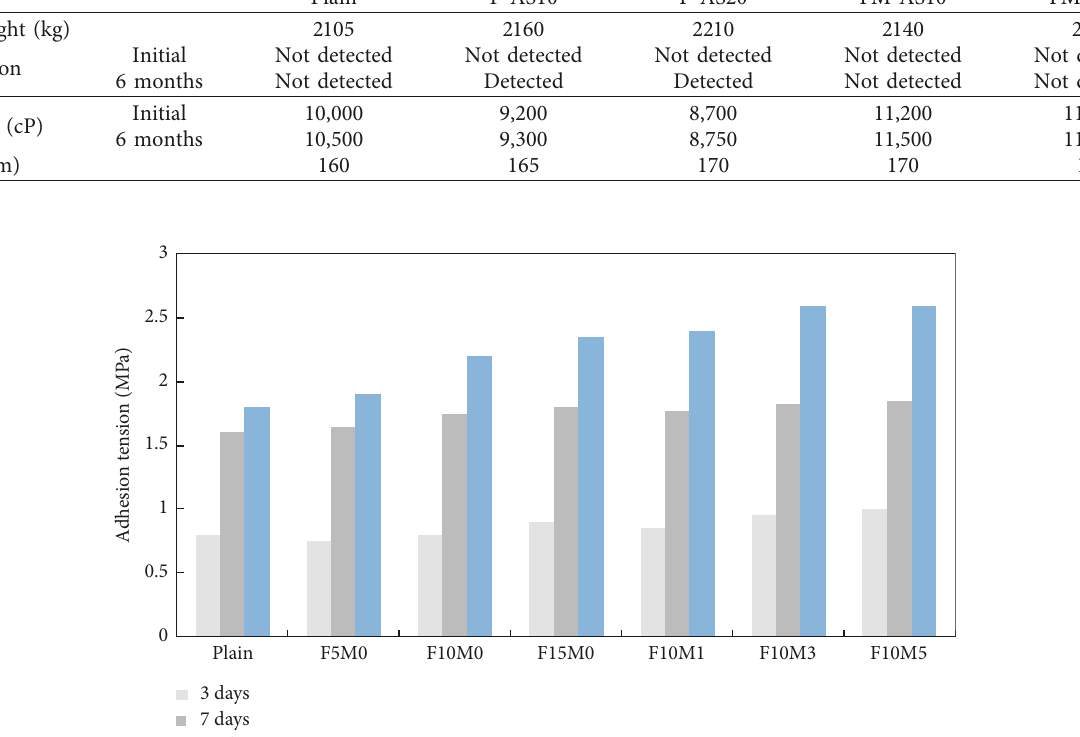
Figure 5: Adhesion tension for the cement mortar with